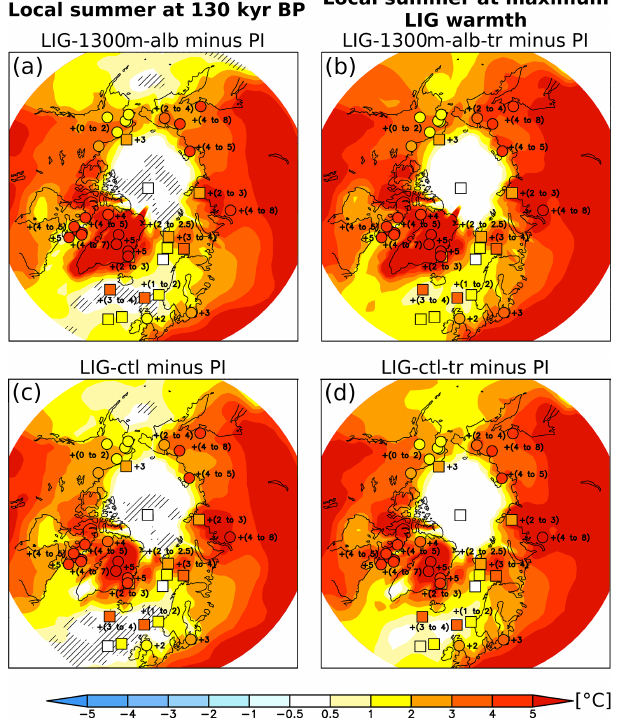
Figure 6. Effect of (a, b) Greenland Ice Sheet elevation, insola- tion, albedo, and atmospheric methane concentration and (c, d) in- solation and atmospheric methane concentration for the Last In- terglacial (LIG) relative to pre-industrial (PI). Model–data com- parison of mean local summer temperature anomalies. The shad- ing represents the simulated surface temperature (TS) anomalies at (a, c) 130kyrBP derived from (a) LIG-1300m-alb and (c) LIG-ctl, and (b, d) summer maximum LIG warmth (warmest 100 warmest months between 130 and 120kyrBP) derived from (b) LIG-1300m- alb-tr and (d) LIG-ctl-tr, relative to PI. Hatched areas in (a, c) mark statistically insignificant TS anomalies. The squares and circles show marine and terrestrial proxy-based maximum LIG summer temperature anomalies relative to PI derived by CAPE-Last Inter- glacial Project Members (2006). The colours inside the squares and circles represent the proxy-based temperature anomalies de- rived from the intervals provided by CAPE-Last Interglacial Project Members (2006), that agree best with the simulated TS anomalies at the location of the